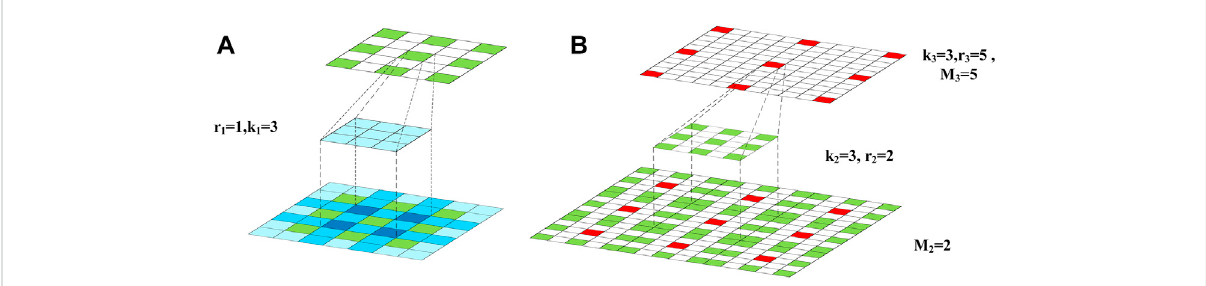
FIGURE 3 The cascaded dilated convolutional layers: (A) The operation of the fi rst dilated convolutional layer; (B) the operation of the second dilated convolutional